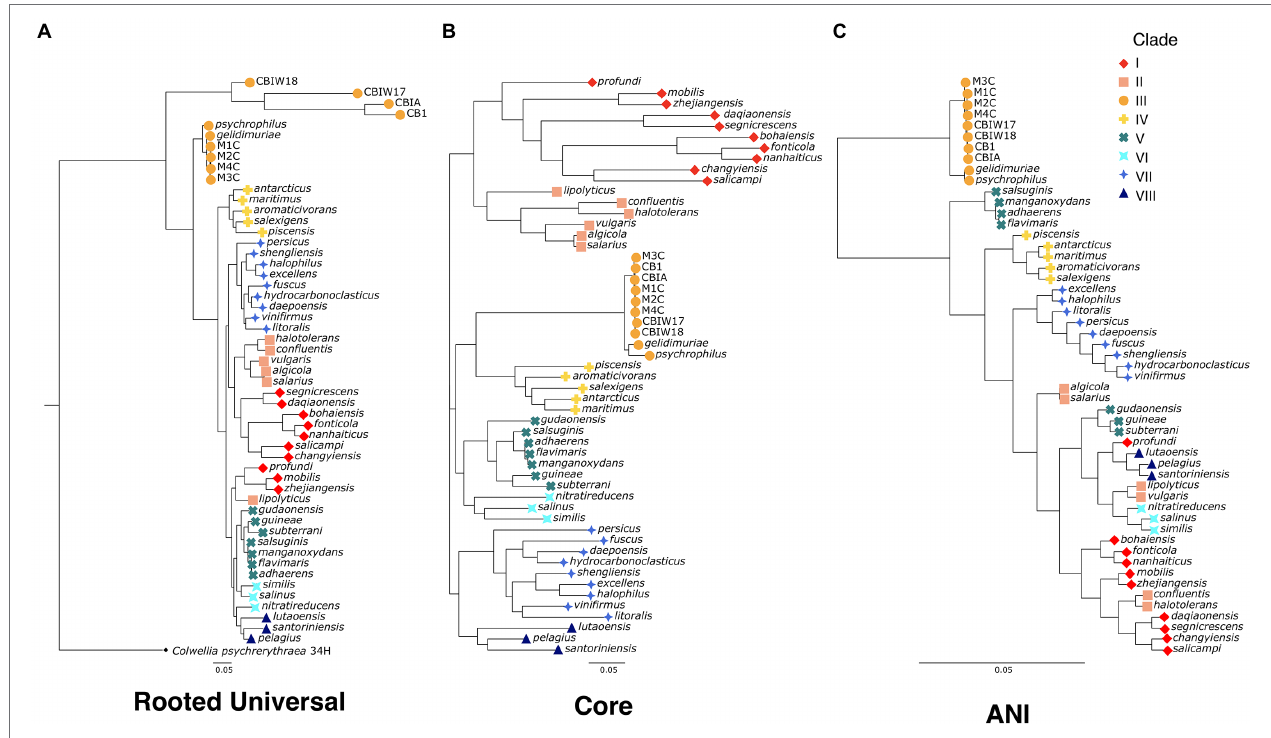
FIGURE 2 | Phylogenetic trees for the genus Marinobacter (A) “rooted universal,” (B) “core,” and (C) “ANI”-based phylogenetic trees for the eight new genomes from cryopegs and 45 other representatives of Marinobacter species. The rooted universal tree (A) is constructed from a set of universal single copy bacterial marker genes ( n = 69) and includes Colwellia psychrerythraea 34H as an outgroup. The core tree (B) is constructed from a set of genes found in single copies in each genome that have ≥ 95% geometric homogeneity and ≤ 90% functional homogeneity across the pangenome ( n = 108). The ANI tree (C) represents the relatedness of each genome based on percentage identity of shared genomic content. The leaves of each tree are coded by color and shape according to the clade to which they